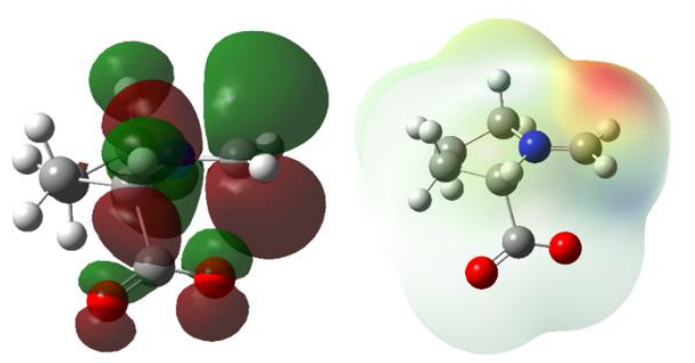
Figure 2. The lowest unoccupied orbital (LUMO) (isoval = 0.02) and electron density (isoval = 0.0004) mapped with LUMO density calculated for the iminium zwitterion 1c .